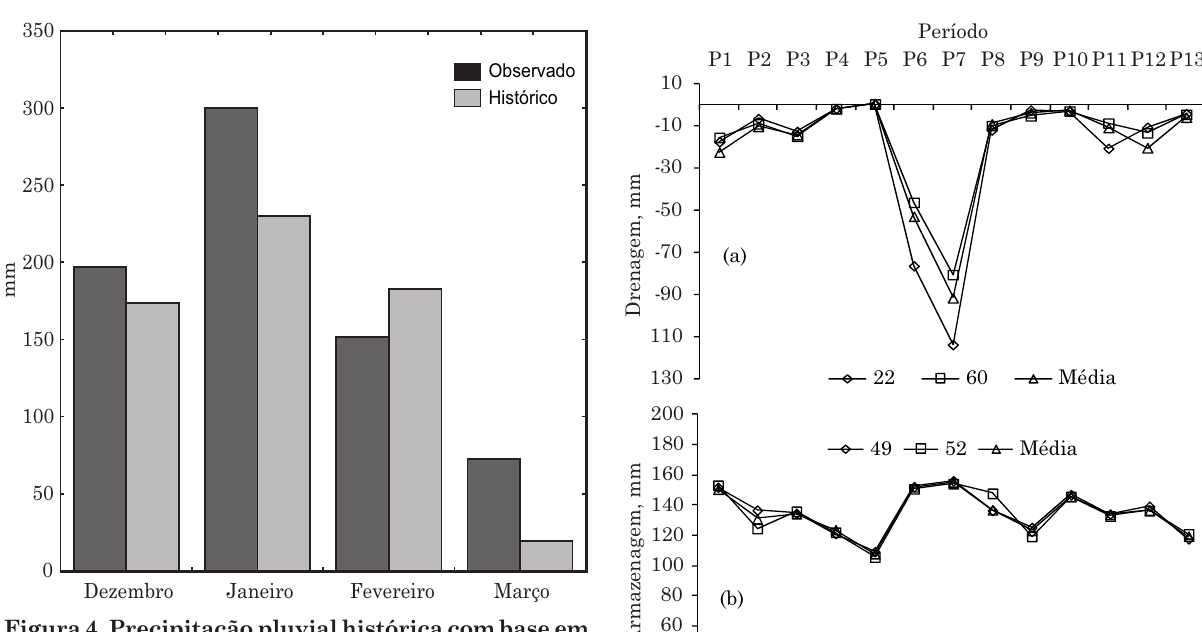
Figura 4. Precipitação pluvial histórica com base em 100 anos e precipitação pluvial observada durante o ciclo da cultura. No mês de março foi contabilizada apenas a média histórica para os 12 dias.